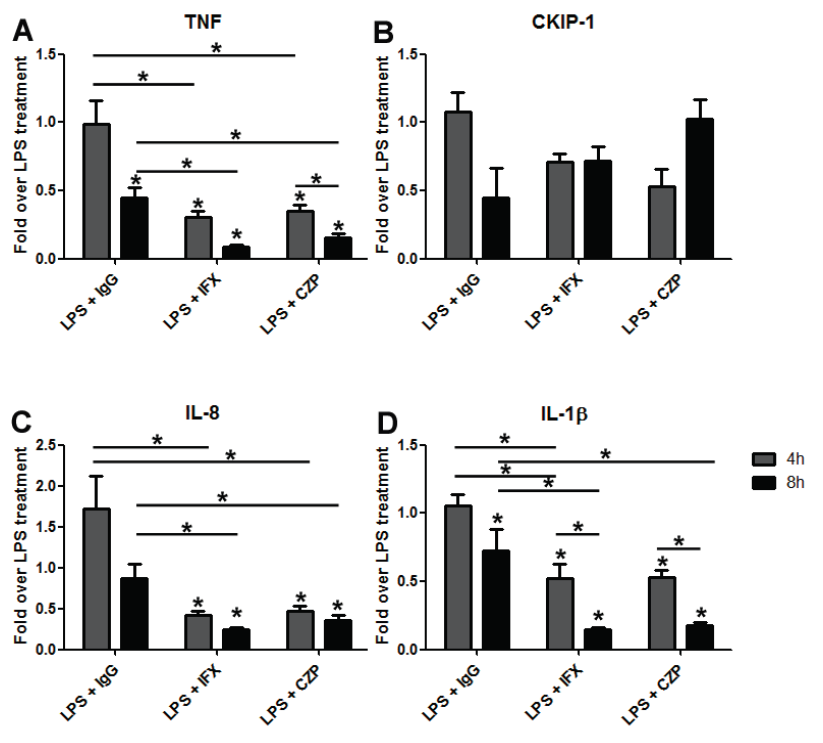
Figure 3. Induction of reverse signaling by distinct anti-TNF monoclonals modulates gene expression patterns in a time-dependent manner. Relative gene expression pattern of TNF ( A ), CKIP-1 ( B ), IL-8 ( C ), and IL-1 β ( D ) were investigated by QRT-PCR on